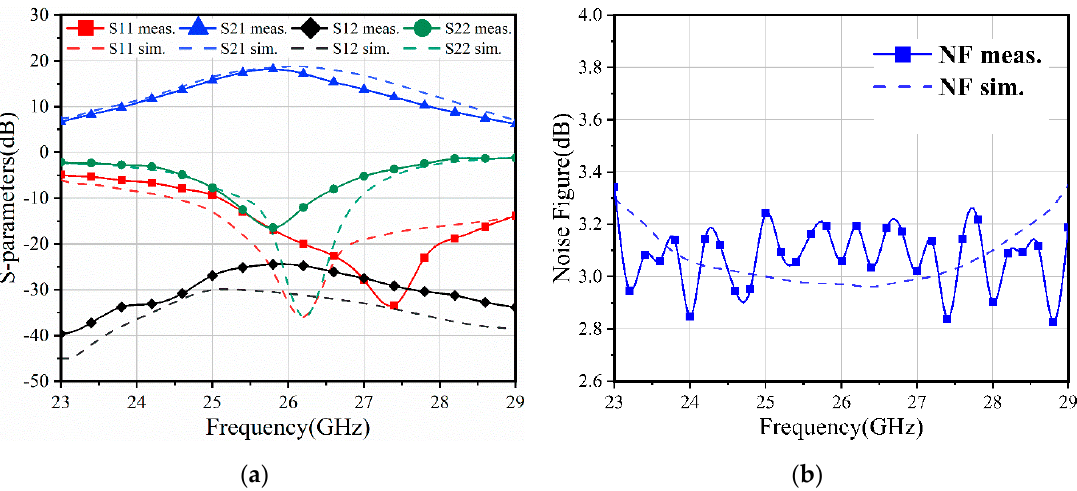
Figure 7. Chip photo of the proposed LNA.